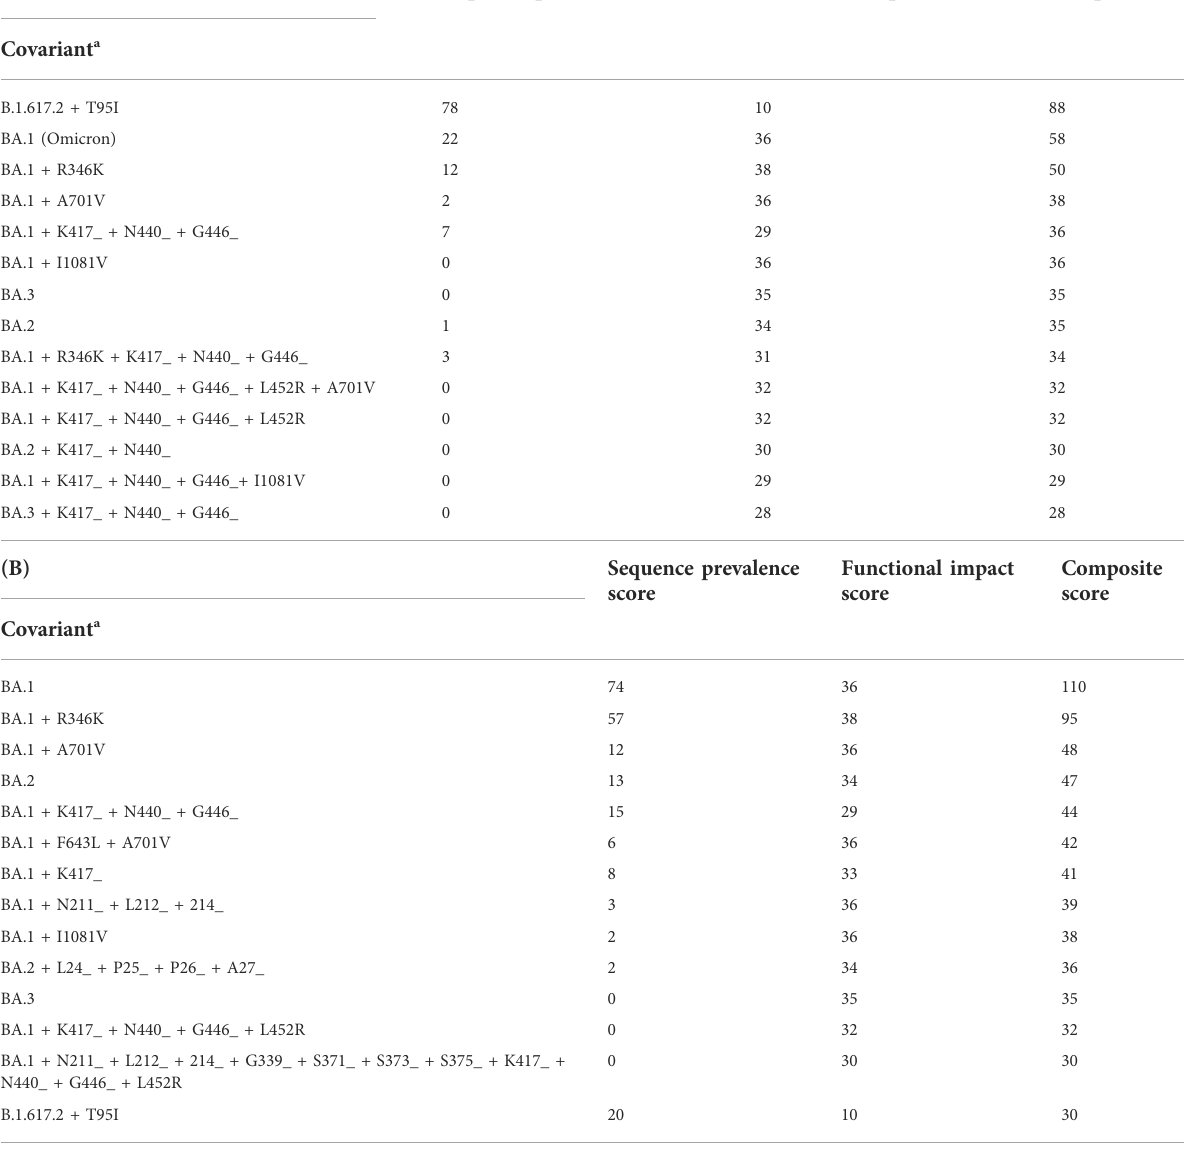
TABLE 3 Global Spike Variant Ranking for a Selected Annotated Lists with the Composite Score. The output ranking from the Composite Score of selected covariants, annotated with names based on the addition or reversion of mutations relative to a PANGO lineage consensus variant constellation. (A) Using GISAID data up to January 2022, the scoring in the last three columns quantitatively capture how these covariants differ, including the increase in functional impact for BA.1 + R346K relative to the ancestral BA.1 and also captures an early signal for the BA.2 founder lineage. (B) Using GISAID data up to February 2022, these scorings capture the 13-fold increase in Sequence Prevalence Score relative to the January results for the same BA.2 founder lineage, strongly fl agging an emerging Variant of